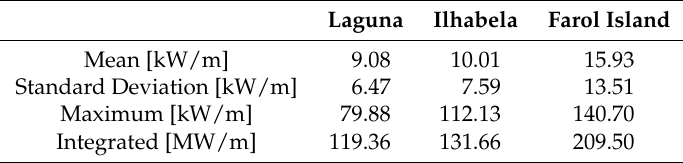
Table 3. Statistical parameters calculated using the time series of each studied point over 18